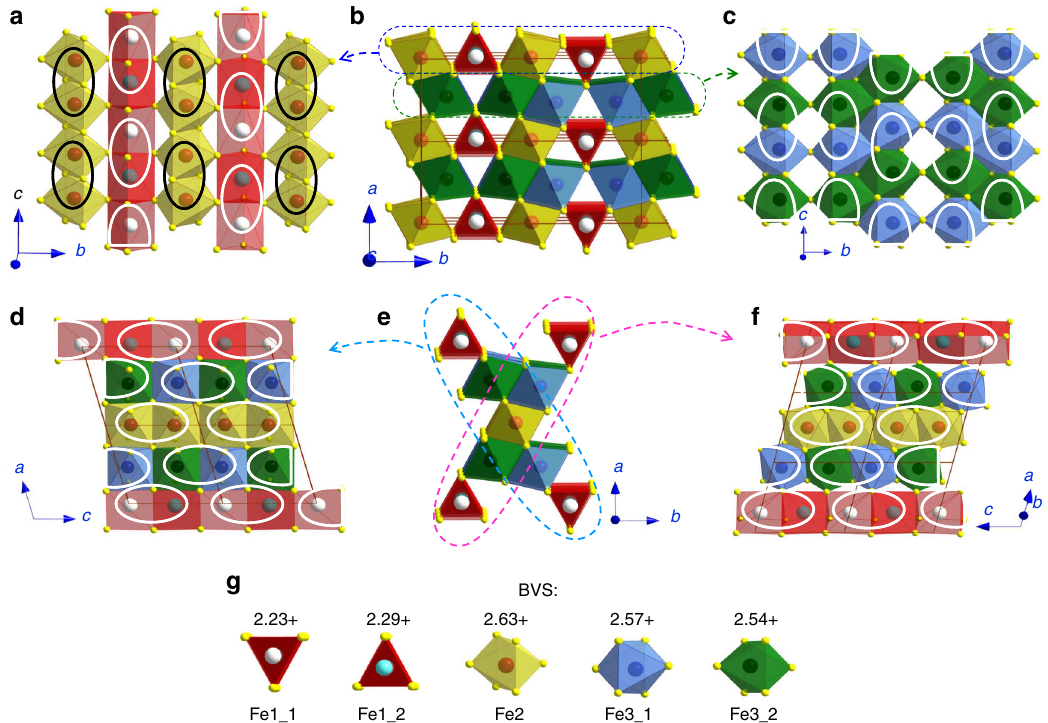
Fig. 6 Monoclinic crystal structure of Fe 4 O 5 -IV. The structure has P 2 1 / m symmetry and plots are based on the crystal structure data re fi ned at 25.2 GPa and at 120 K. a Projection of the trigonal prisms Fe1 and single chains of Fe2 octahedra. b Two unit cells projected down the c -axis. Thin solid lines indicate the unit cell edges. c Projection of the double chains of Fe3 octahedra. d Projection down the b -axis of one of the two diagonal ribbons shown in e . e Two characteristic diagonal ribbons consisting of fi ve iron chains each. f Projection down the b -axis of one of the two diagonal ribbons shown in e . Solid ellipsoids are dimers formed in all iron chains. Different crystallographic positions are shown in different colors. g Bond valence sums (BVS) values of all the